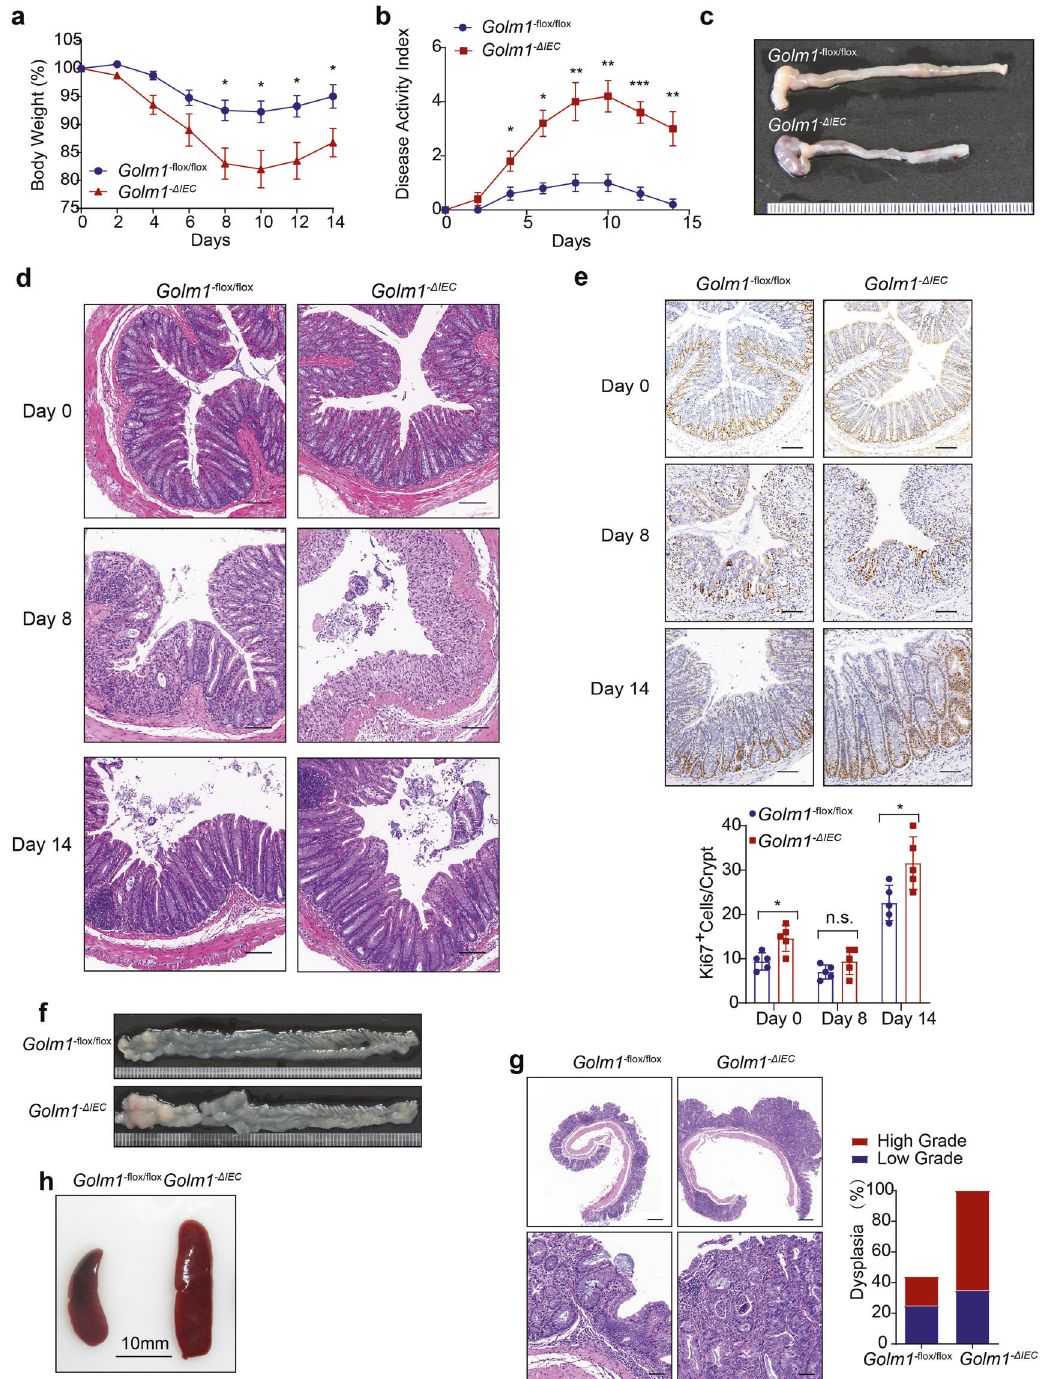
The intestinal epithelial barrier serves as the prime protective layer from luminal antigens and their impairment has been frequently linked with IBD and CAC. 5 We detected